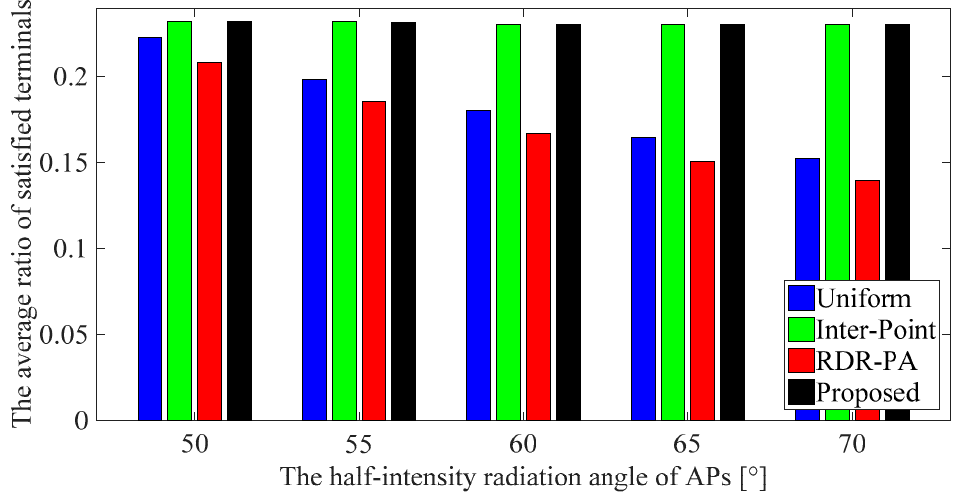
Figure 14. The average ratio of satisfied terminals versus half-intensity radiation angle.